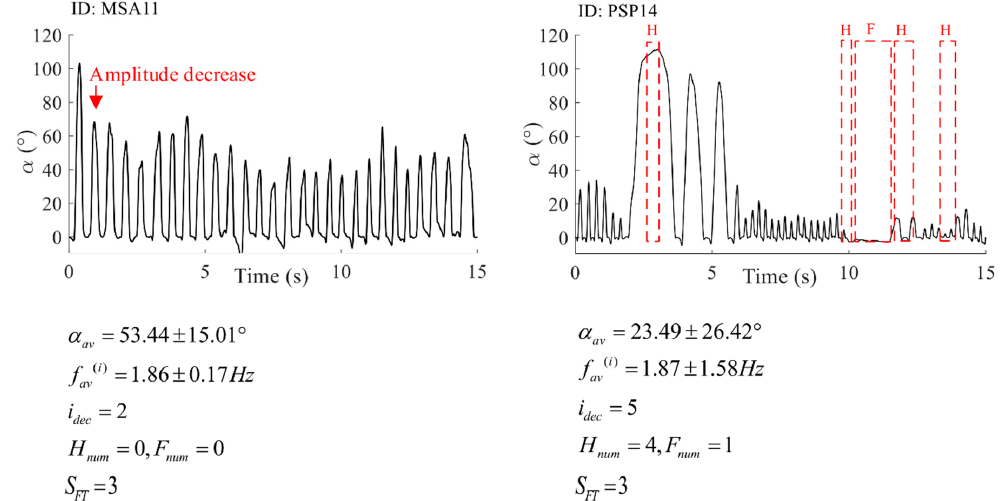
Figure 10. The result of the expert system comprising a graphical representation with detected irregularities, calculated features, and the final score. The example is given for one MSA patient (ID: MSA11), right hand, and one PSP patient (ID: PSP14), right